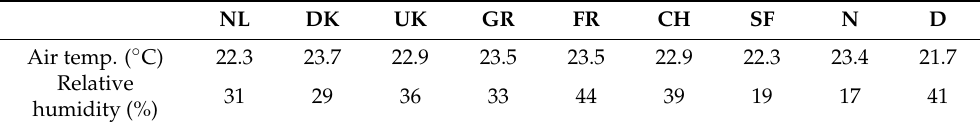
Table 4. Average results of the thermal measurements in each country